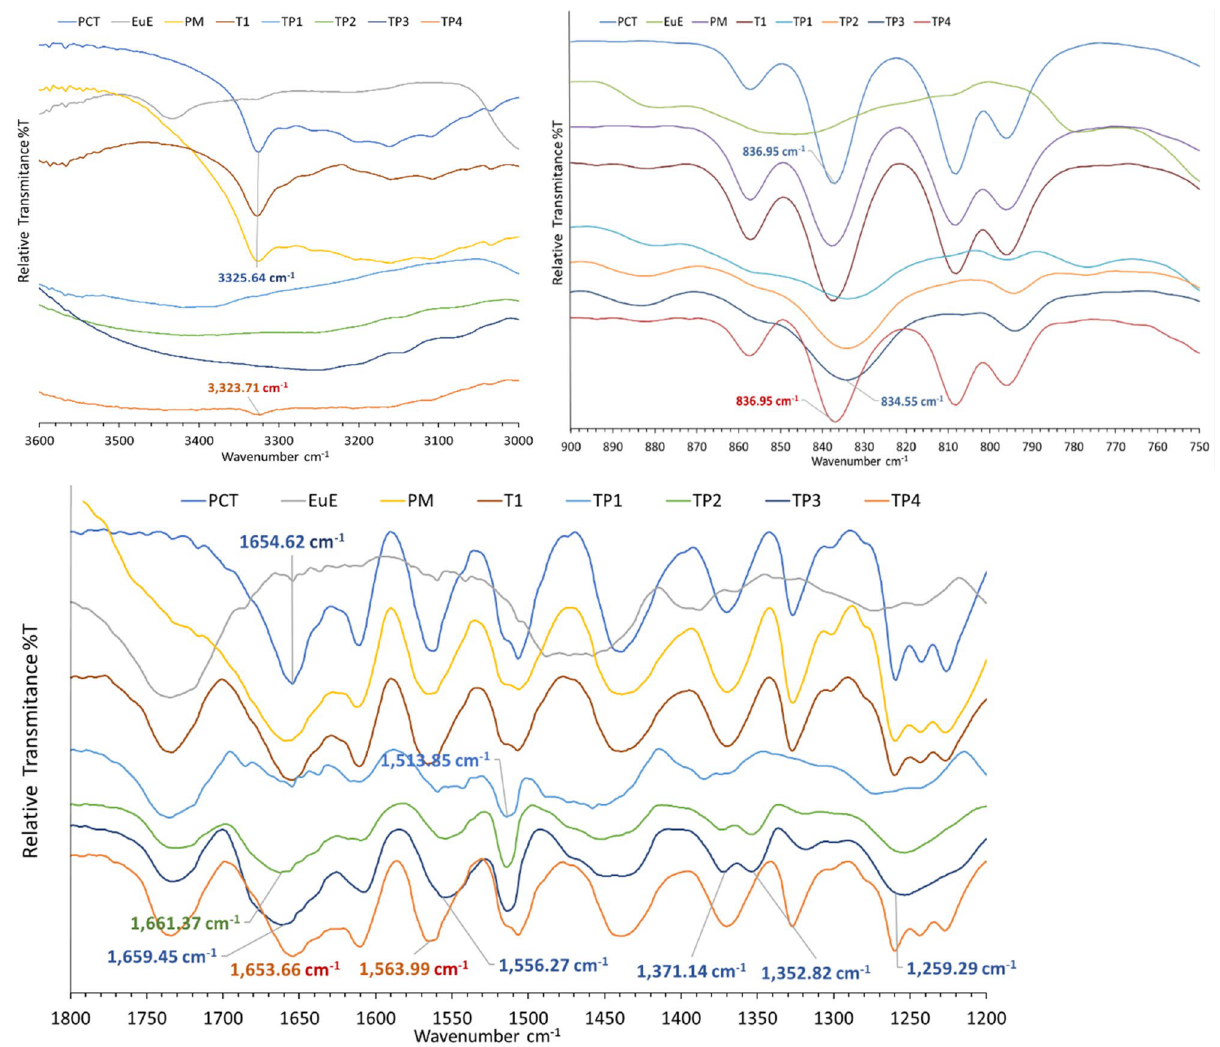
Figure 6. IR spectra of PCT, EuE, 1:1 PM, T1, and TP trials.